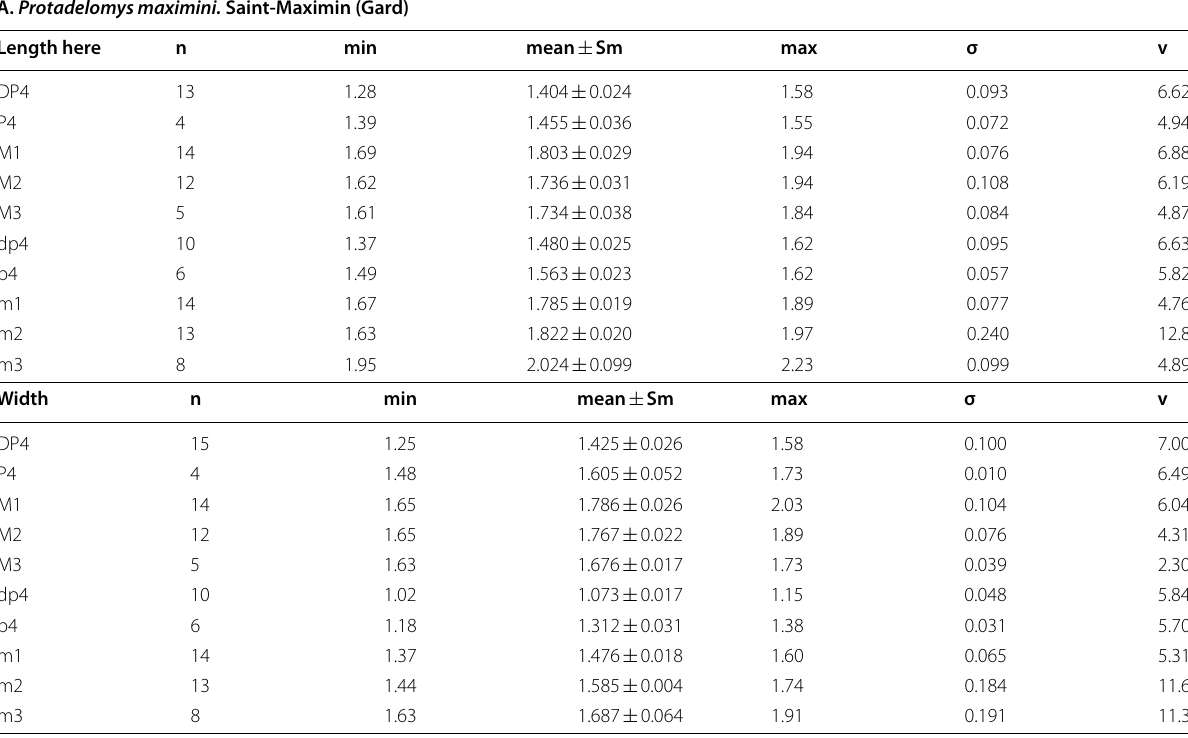
Sm σ/ √ n ; v 100 σ/average L or W). of the different ± = =